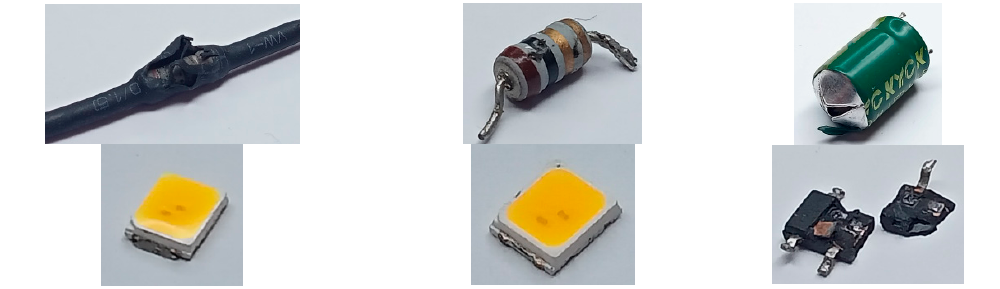
Figure 7. Physical failure effects of test components for critical surge levels.